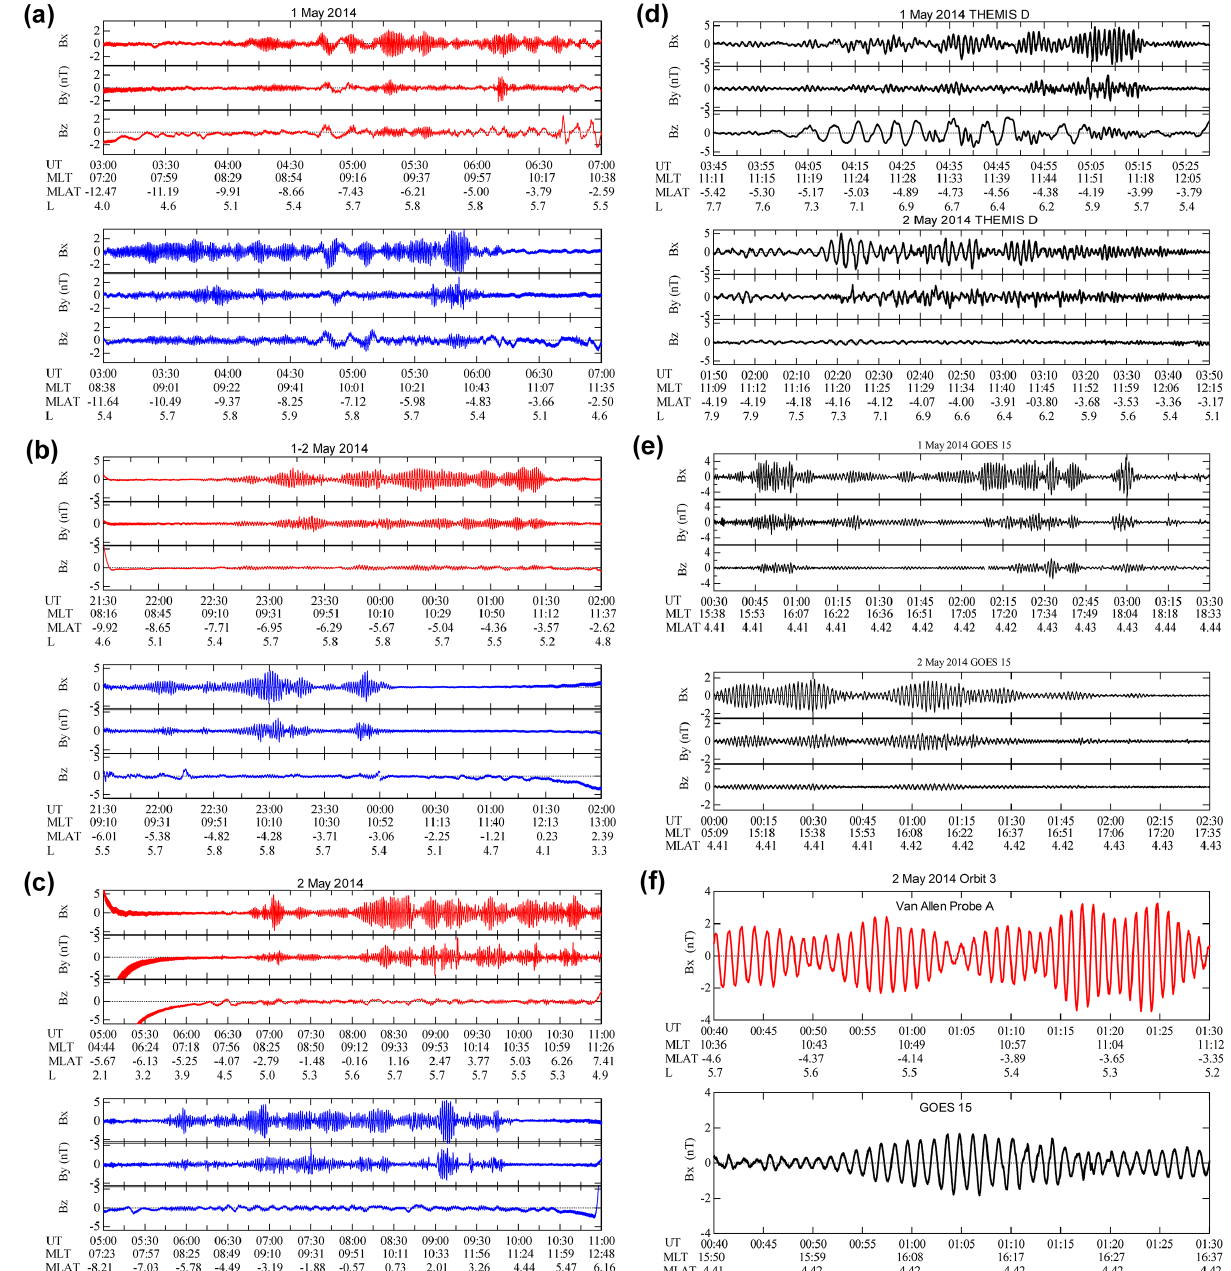
Figure 5. (a) Magnetic field observations in field-aligned coordinates from Van Allen Probes A ( plotted in red) and B (plotted in blue) from 03:00 to 07:00UT on 1 May 2014 (Orbit 1). The Z axis is in the direction of the averaged magnetic field. The Y axis is transverse to B and to the radius vector from the Earth to the spacecraft and is directed approximately azimuthally eastward. The X axis completes the right-handed system and is directed approximately radially outward from Earth. The location of the satellite is shown in the bottom where L is the equatorial distance to the field line, MLAT is magnetic latitude in degrees and MLT is the magnetic local time in hours. (b) Magnetic field observations in field-aligned coordinates from Van Allen Probes A and B from 21:30UT on 1 May 2014 to 02:00UT on 2 May 2014 (Orbit 3). (c) Magnetic field observations in field-aligned coordinates from Van Allen Probes A and B from 05:00 to 11:00UT on 2 May 2014 (Orbit 4). (d) Magnetic field observations in field-aligned coordinates from THEMIS D from 03:45 to 05:30UT on 1 May 2014 (Orbit 1) and from 01:50 to 03:50UT on 2 May 2014 (Orbit 3). (e) Magnetic field observations in field-aligned coordinates from GOES 15 from 00:30 to 03:30UT on 1 May 2014 (Orbit 1) and from 00:00 to 02:30UT on 2 May 2014 (Orbit 3). (f) The radial components of the Pc4 pulsations observed by the Van Allen Probe A and GOES 15 spacecraft from 00:40 to 01:30UT on 2 May 2014 during Orbit